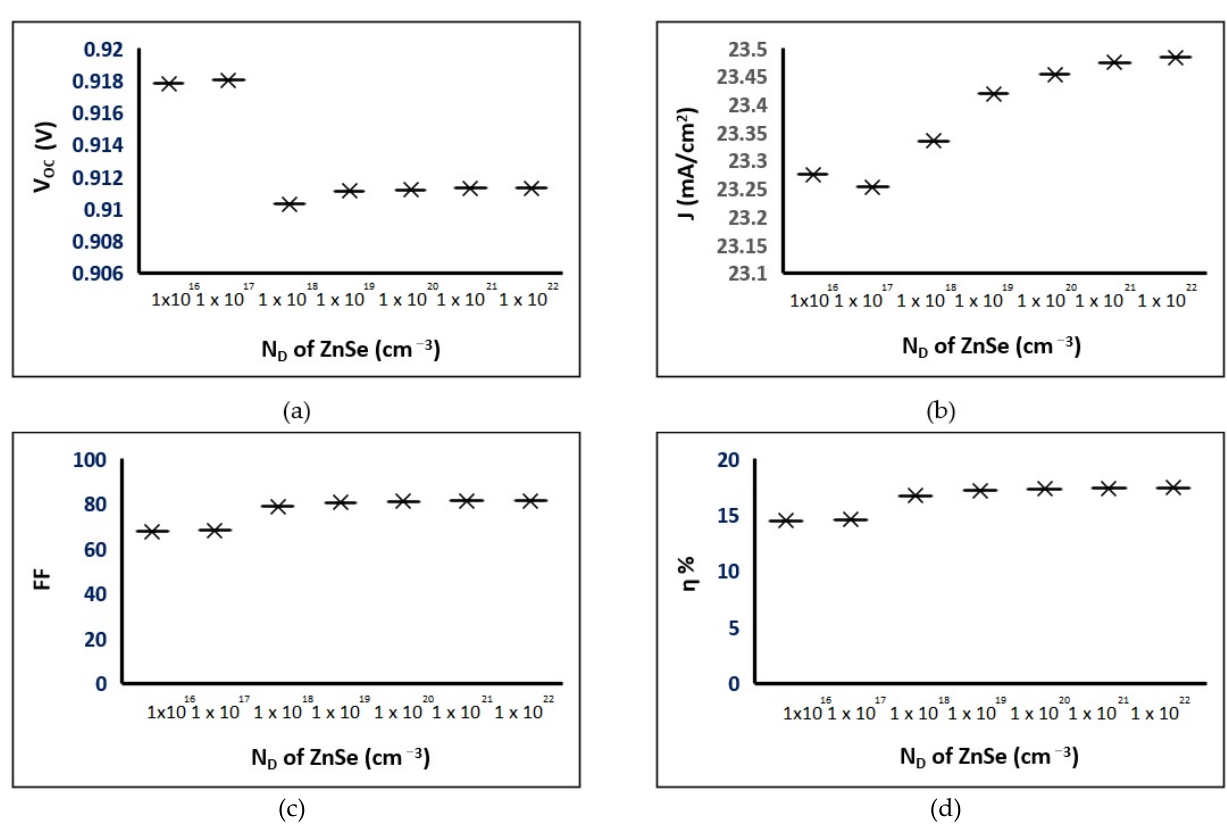
Figure 6. The simulated electrical performance parameters as a function of donor charge carrier concentration ( N D ): ( a ) V OC , ( b ) J SC , ( c ) FF , ( d ) η . Table 6. Effective of the donor charge carrier concentration ( N D ) on the electrical cell performance parameters, at T = 300 K.